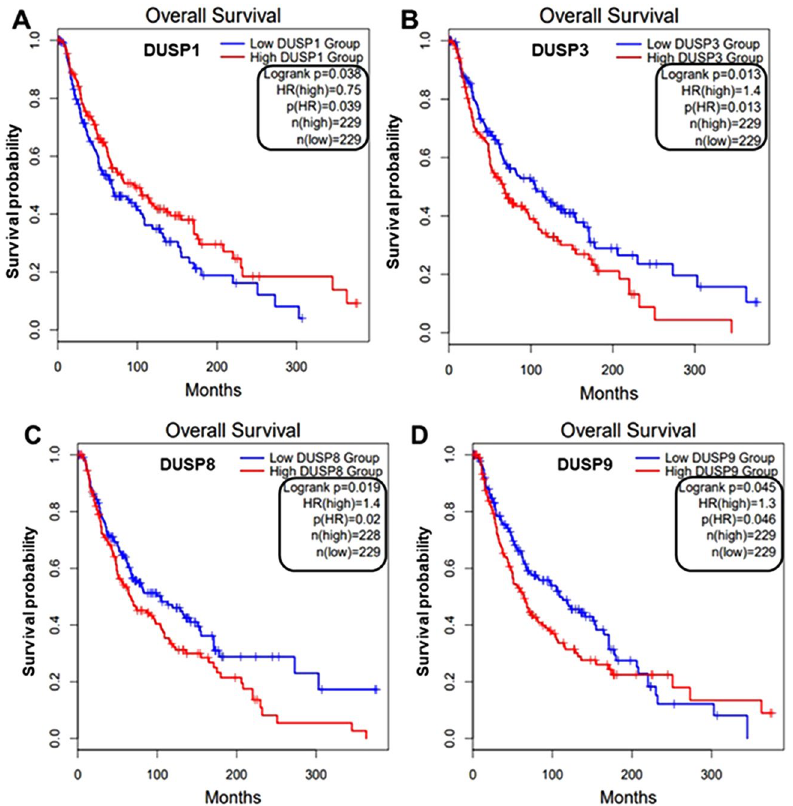
Figure 5. Prognostic significance of DUSPs in melanoma. Kaplan–Meier survival analysis of a cohort of melanoma patients in the TCGA-SKCM datasets for overall survival Patients were stratified based on the median expression (low- blue and high- red) of DUSP1, DUSP3, DUSP8, and DUSP9. Log rank test, hazard ratio (HR) are